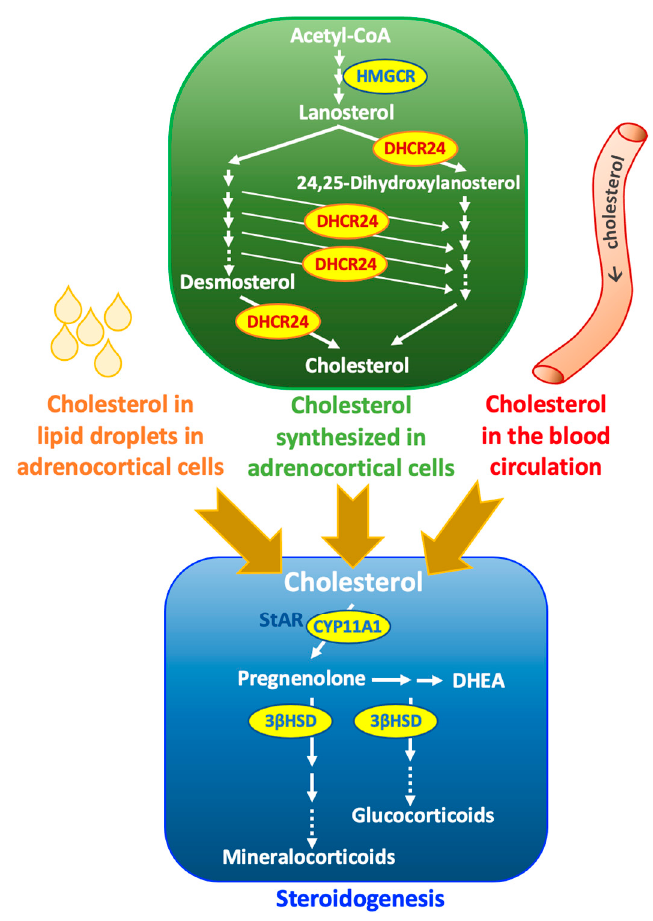
Figure 1. Cholesterol synthesis and steroidogenesis in the adrenal gland.